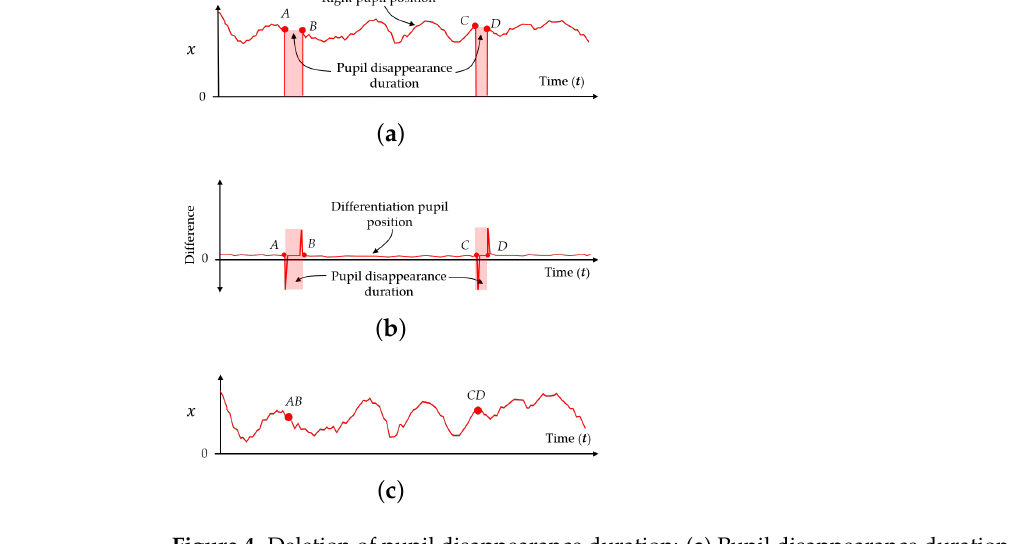
Figure 4. Deletion of pupil disappearance duration: ( a ) Pupil disappearance duration, ( b ) Differenti- ation of pupil position, and ( c ) Modified of pupil position.